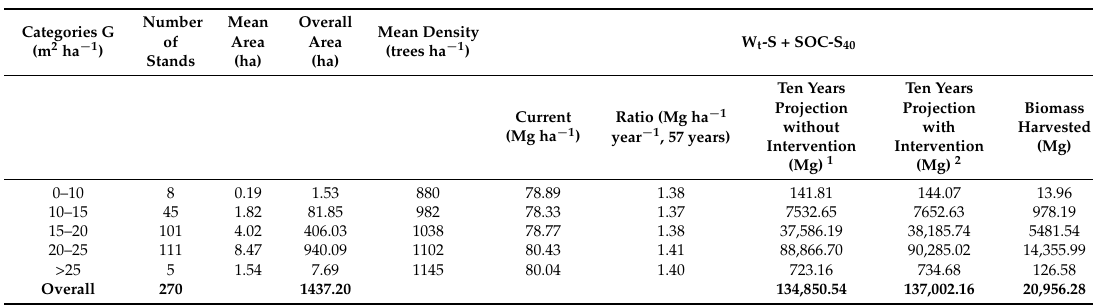
Table 4. Stands characteristics according to semi-automatic forest stand delineation (Orpheo ToolBox software) and basal area (G) and 10-year C stock projections (biomass and soil organic carbon stock at 0–40 cm soil layer; W t -S, SOC-S 40 ) of Pinus halepensis plantations at Los Cuadros (Murcia, Spain) under different